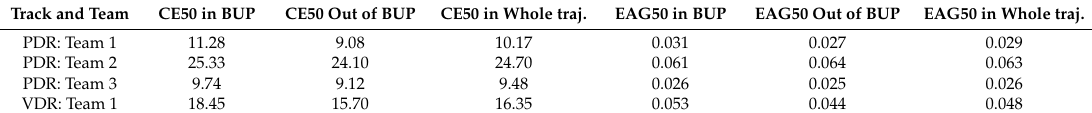
Table 7. Comparison of the CE50 and EAG50 values in/out of BUP.